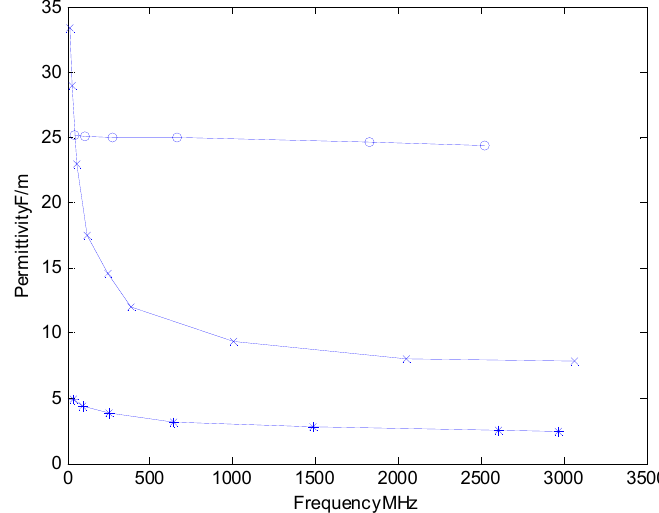
Figure 1. Illustration detailing the dramatic differences in the permittivity response of sand “o” near saturation, versus bentonite clay “x” at 30% volumetric moisture, and bentonite clay “*” at 5% volumetric moisture (m/m). Of particular note is the additional information available in the frequency domain that is available, from a wide-bandwidth interrogation of the soil, which has the potential for the development of auto-calibration algorithms which can sense the soil type, without the need for a laboratory calibration which is currently required in high accuracy field